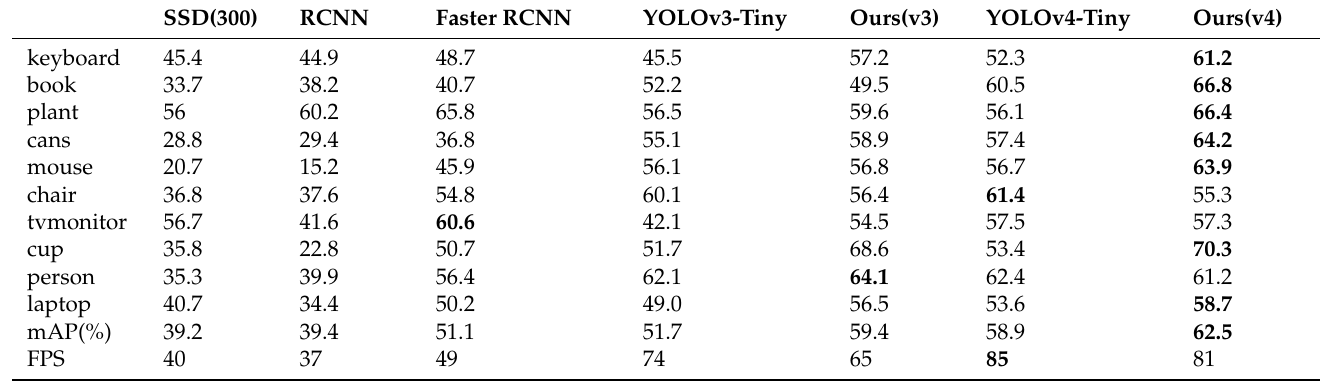
Table 8. Comparison of the AP value and speed of different networks only on the TUM dataset.